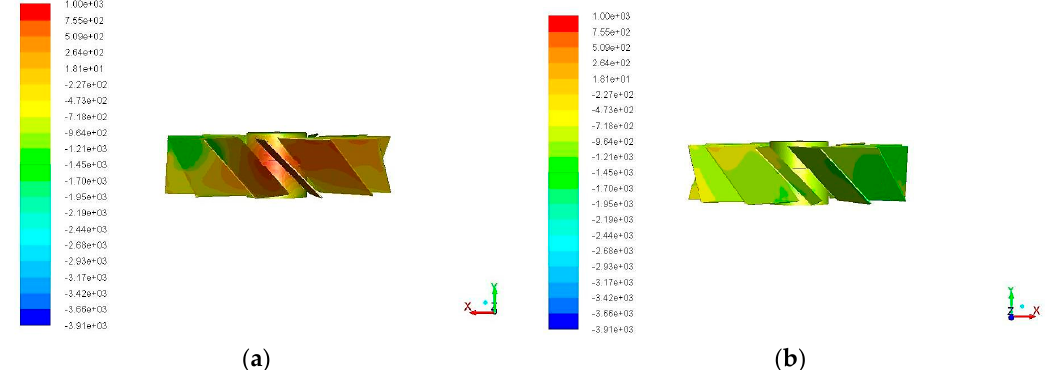
Figure 12. Static pressure (Pa) distribution ( a ) on the contested surface; ( b ) on the non-contested surface of a one-stage KIONAS, rotor blade angle of 45 degrees and stator with flat guide vanes.